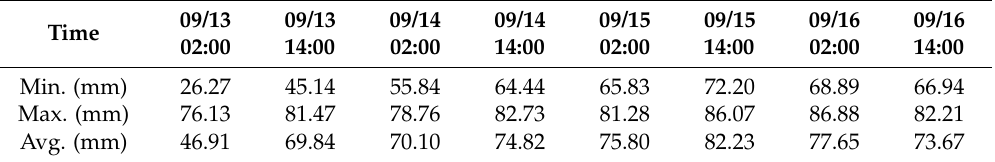
Figure 13. PWV changing before and after the MERANTI landfall. The green five-point-star denotes the location of typhoon epicenter at the particular time in each subfigure marked with ( a – f ). Table 2. The minimum, maximum, and average precipitable water vapour (PWV) over Zhejiang province every 12 h from 02:00 on 13 September to 14:00 on 16 September 2016.